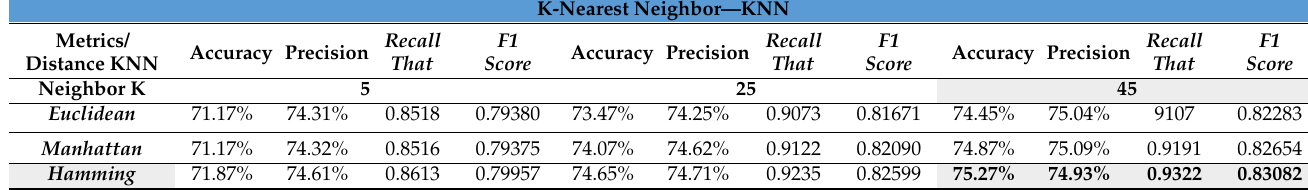
Table 5. Benchmark for K-Nearest Neighbor—KNN.